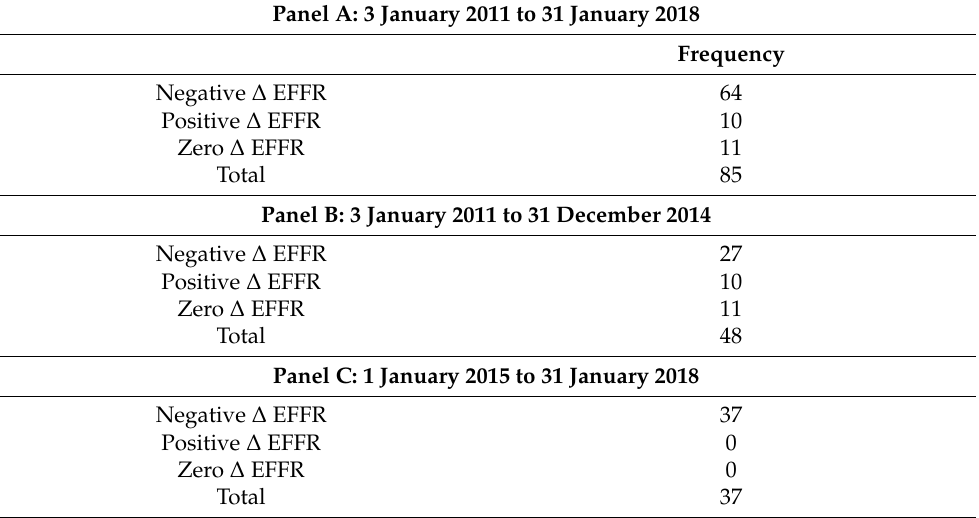
Table 2. Frequency of ∆ Effective Federal Funds Rate at month